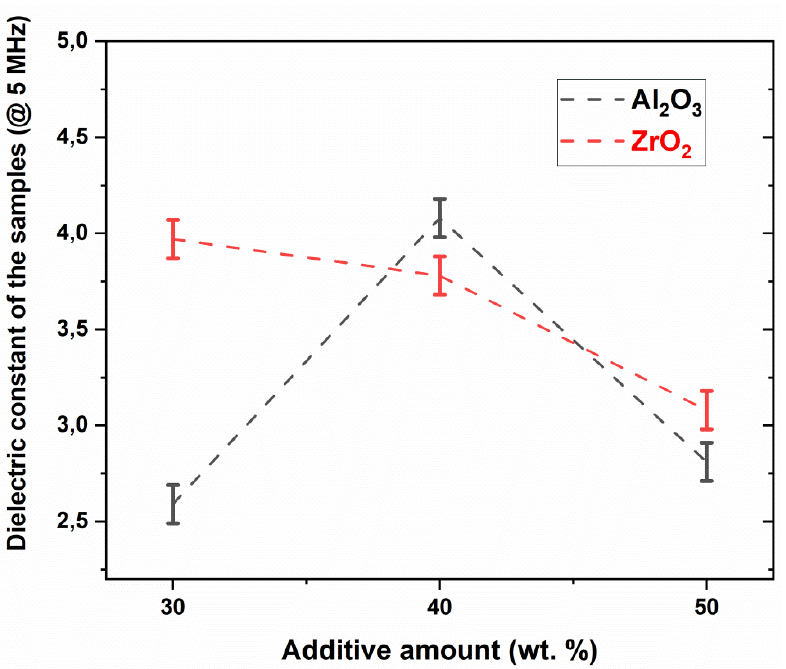
Figure 9. Dielectric constant of the samples according to the varying amounts of Al 2 O 3 and ZrO 2 additives. Table 3. Thermal conductivity of the